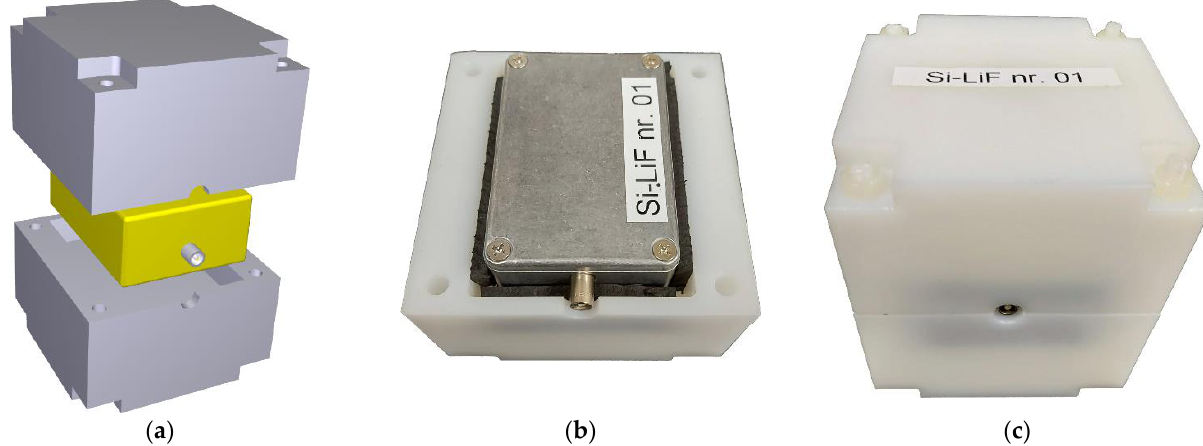
Figure 4. ( a ) 3D sketch of the SiLiF detector (in yellow) and its arrangement within the moderator (in grey); ( b ) a SiLiF hosted in a half moderator; ( c ) final assembling of a SiLiF.